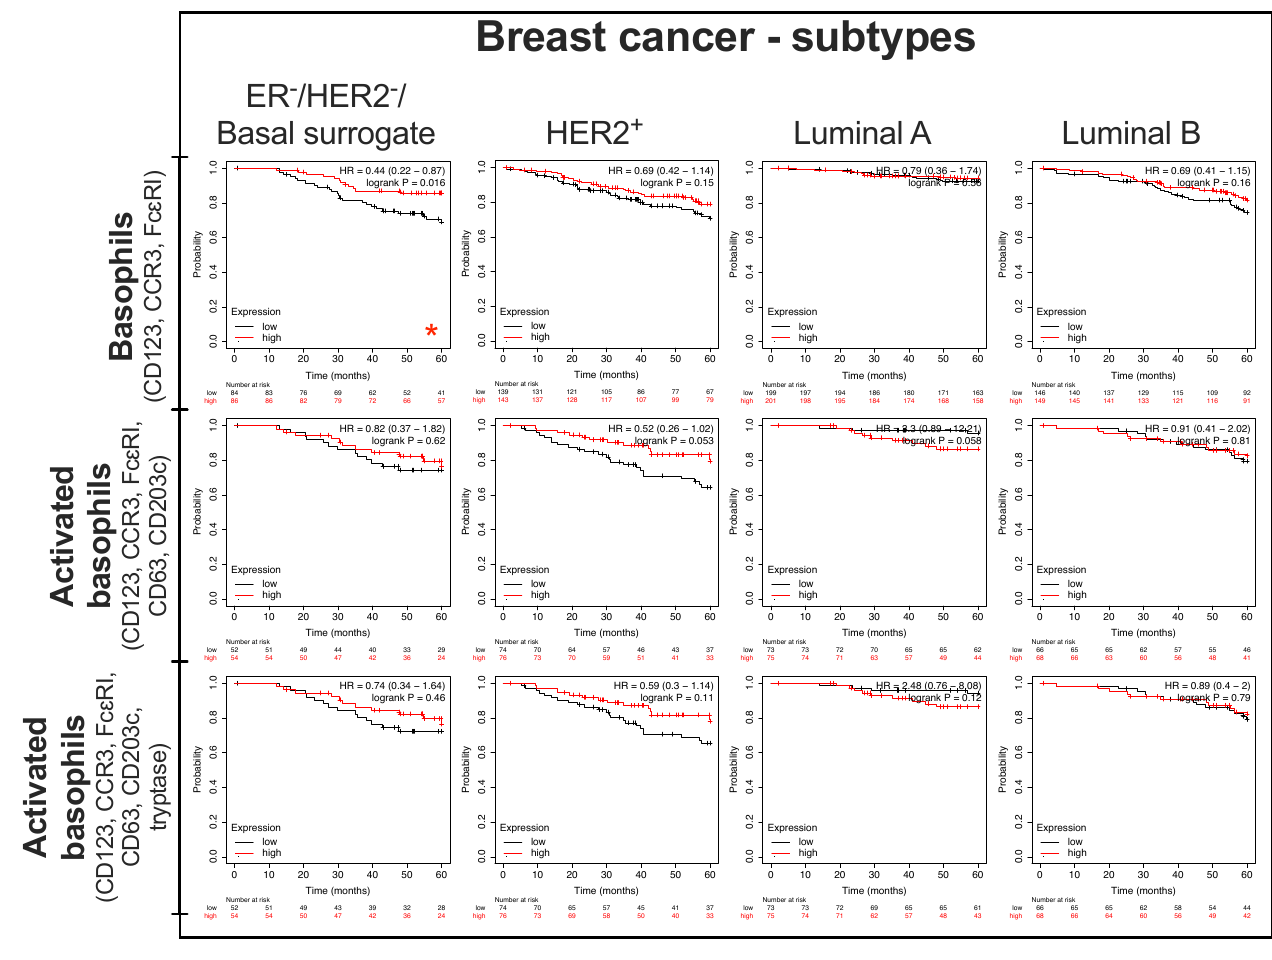
Figure 3. Tumor-resident basophils and clinical outcomes in different breast cancer subtypes. Survival outcome analysis was performed using the Kaplan–Meier (KM) Plotter online tool (https://kmplot. com/analysis/, accessed on 7 December 2021) [71]. Gene expression analyses of tumor-resident basophils (CD123, CCR3, and Fc ε RI) and activated basophil signatures (CD123, CCR3, Fc ε RI, CD63, CD203c ± tryptase) were performed. Patient survival outcomes were analyzed over 60 months. Groups of patients were selected based on combined gene expression levels of selected basophil markers in tumor lesions, into top tertile (T3) and lower tertile (T1). Patients in the middle tertile (T2) were excluded. Markers (Gene Probe ID): CD123 (206148_at); CCR3 (208304_at); Fc ε RI (211734_s_at); CD63 (200663_at); CD203c (232737_S_at) and tryptase (210084_x_at). Summary of n numbers (number of individuals at risk) can be found in Supplementary Table S3. Data sourced though mRNA gene chip. p values: * = p <